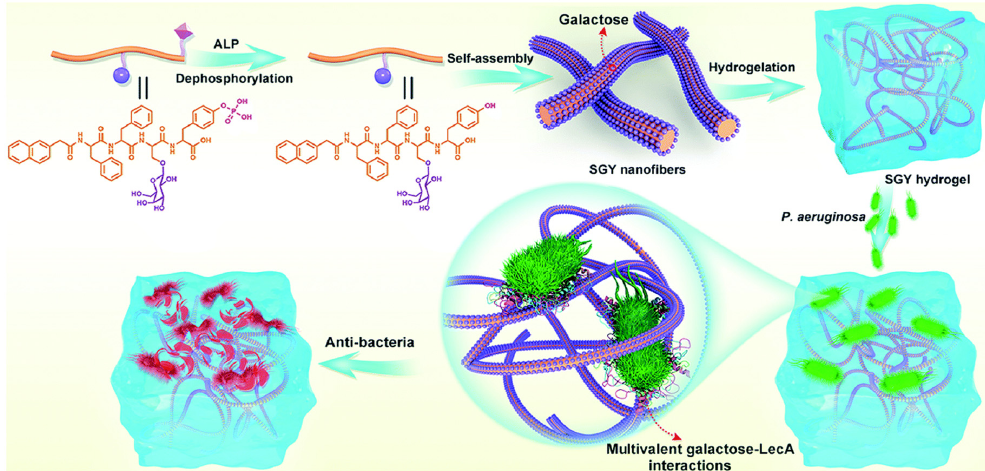
Figure 69. Enzyme instructed self-assembly and antibacterial properties of a galactose-based gelator. Reprinted with per-